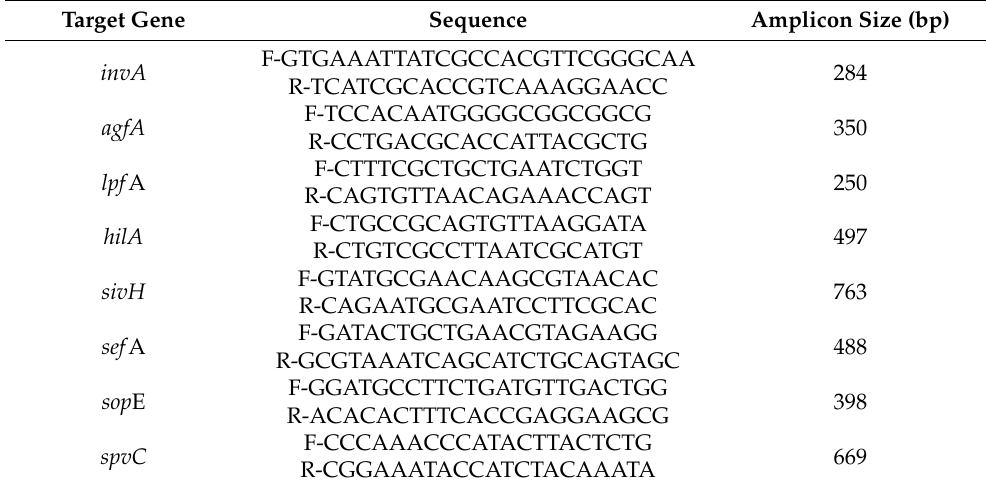
Table 2. Primers used to screen for each of eight virulence genes in Salmonella spp. Using PCR *. Target